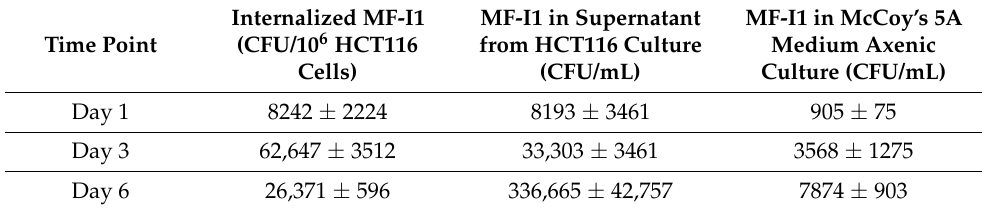
Table 1. Invasion of HCT116 cells by Mycoplasma fermentans MF-I1. MF-I1 in Supernatant Internalized MF-I1 from HCT116 Time Point (CFU/10 6 HCT116 Cells)